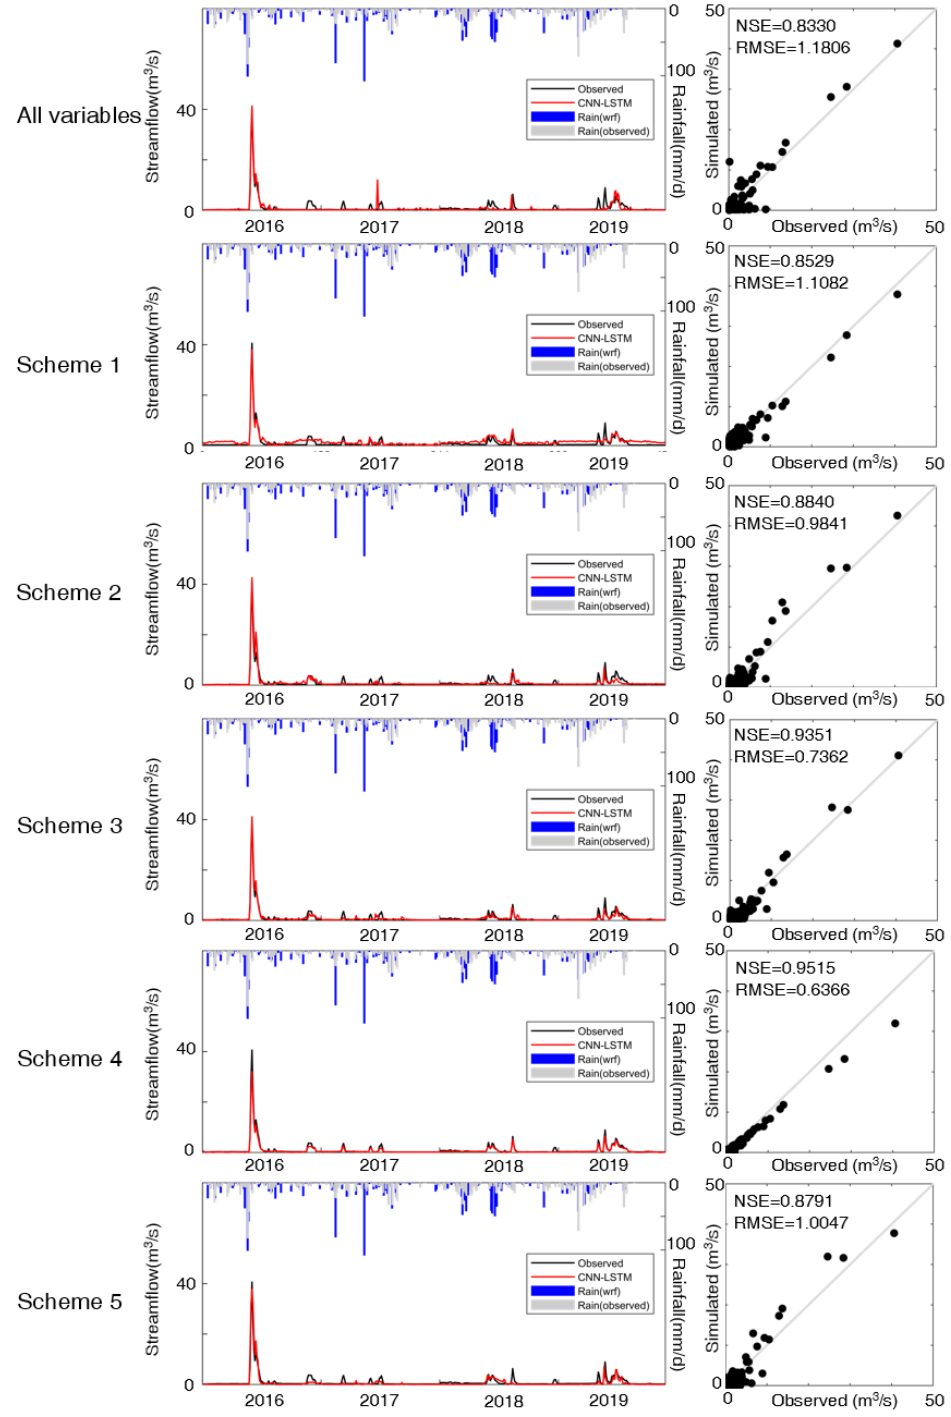
Figure 6. Performance of the CNN-LSTM model in the Zijingguan catchment during 2016–2019. For the Fuping catchment (Figure 5), the performances of the CNN-LSTM models with all input combination schemes were satisfactory (NSE > 0.9). The streamflow processes were simulated accurately, and the peak times were consistent with the observed value. For all models constructed with different input schemes, the simulated peak discharges in 2016 were lower than the observed values. Scheme 4 had